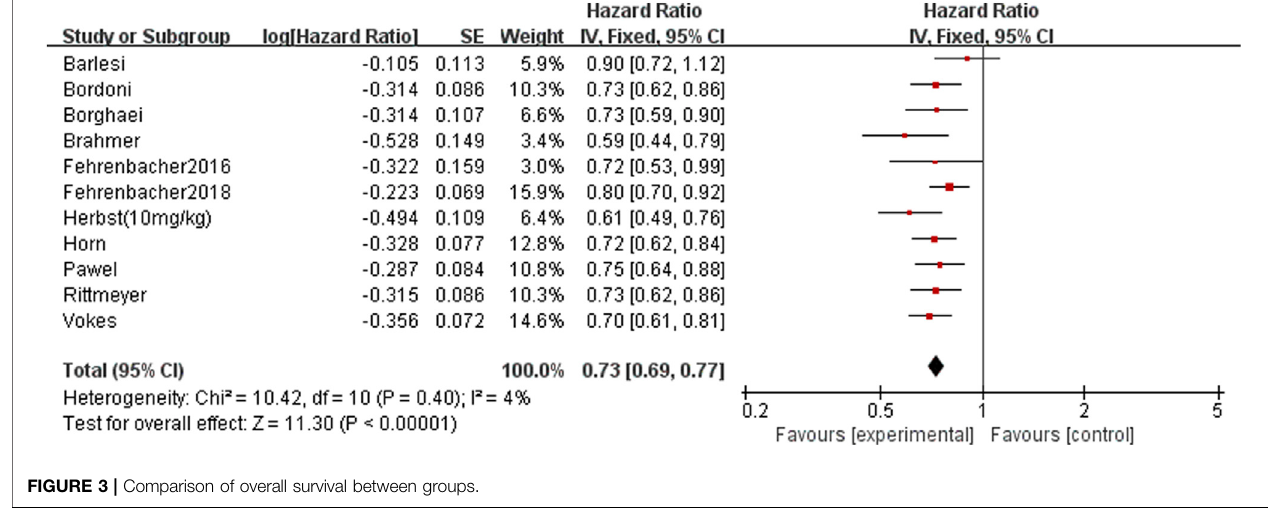
FIGURE 3 | Comparison of overall survival between groups.